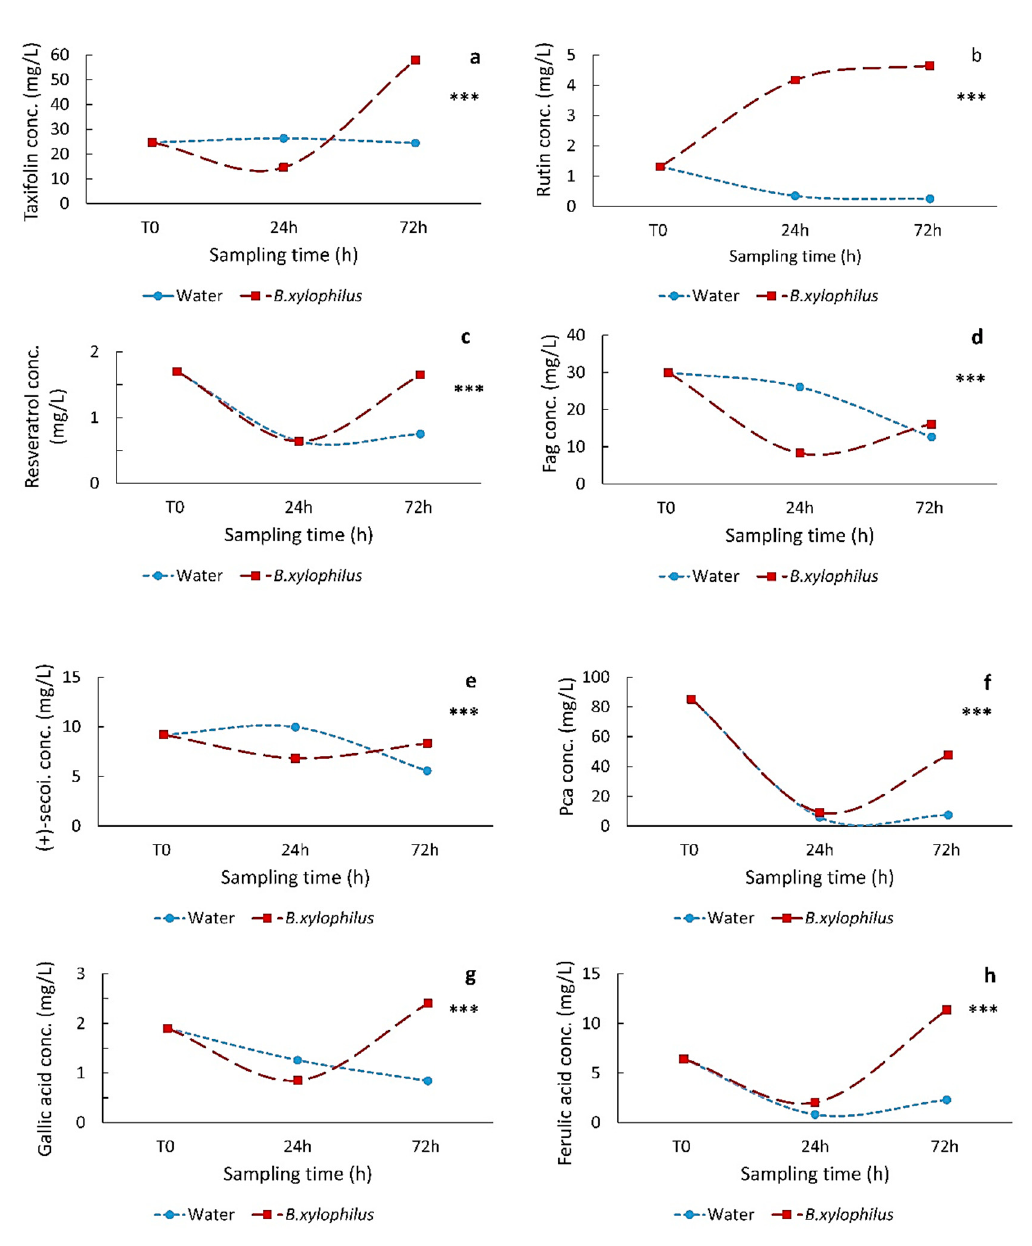
Figure 5. Plot of means of two-way interaction (treatment × sampling time, ANOVA test) for taxifolin ( a ), rutin ( b ), resveratrol ( c ), fag—ferulic acid glucoside ( d ), and (+)-secoisolariciresinol ( e ) in P. halepensis ; pca- protocatechuic acid hexoside ( f ), gallic acid ( g ), and ferulic acid ( h ) in P. sylvestris . Significant differences are indicated by an asterisk (*** p < 0.01).